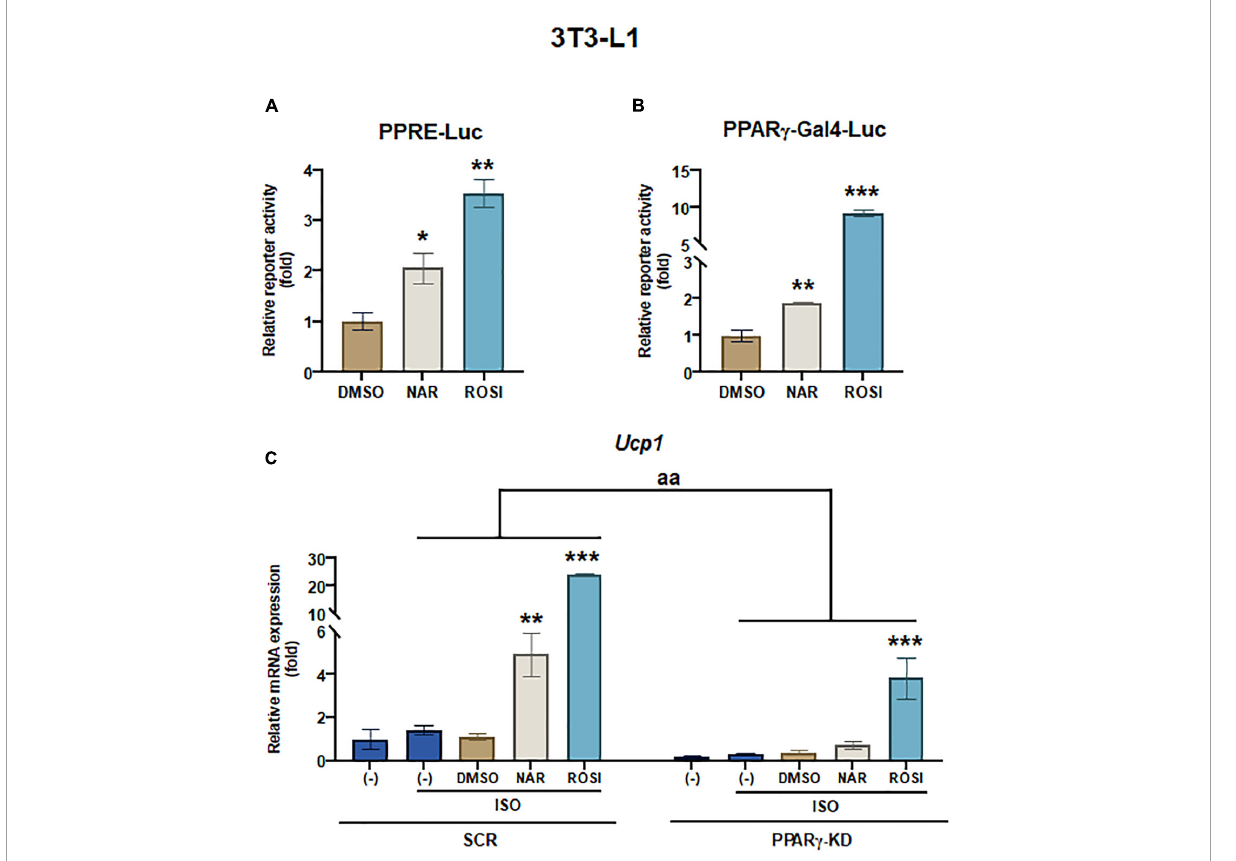
FIGURE4 Naringenin activates PPRE and peroxisome proliferator-activated receptor gamma (PPAR γ ) reporters, and peroxisome proliferator-activated receptor gamma (PPAR γ ) knockdown attenuates the up-regulation of Ucp1 mRNA expression by naringenin in isoproterenol (ISO)-stimulated 3T3-L1 adipocytes. (A,B) Effects of NAR on PPAR activation. 3T3-L1 cells were transiently transfected with PPRE-Luc (A) or murine PPAR γ trans -activation reporter and the β -gal control plasmid (B) as described. Then the cells were treated with NAR, ROSI, or DMSO for 18 h, and